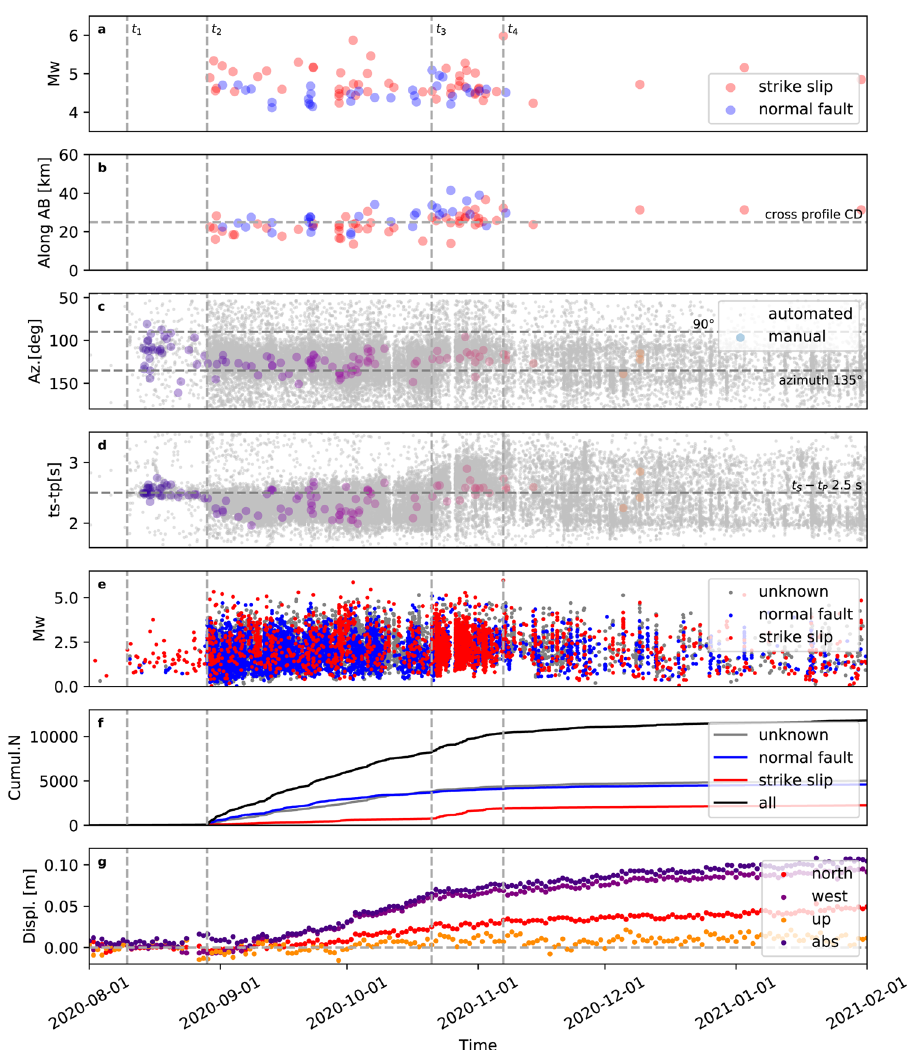
Fig. 4 Sequence timeline. The fi gure shows the results from different techniques: moment tensor inversion results ( a magnitudes, and b horizontal projection along the pro fi le AB in Fig. 2, colored according to the two predominant focal mechanisms); single station analysis at station JUBA ( c , backazimuths of polarized P phases, and ( d ) differential S-P time as a proxy for the source-receiver distance, colored based on automated and manual picks); template matching ( e , magnitude, and f cumulative number of detections, colored based on the focal mechanism of the template events, only events with threshold at 12 times the MAD and cross correlation values above 0.55 are shown, see Supplementary Note 7); observations from the GNSS station DAL5 ( g cumulative displacements since the unrest start).) Dashed lines mark the onset of different phases of seismicity: early weak seismicity (t 1 , August 10, 2020), increased seismicity (t 2